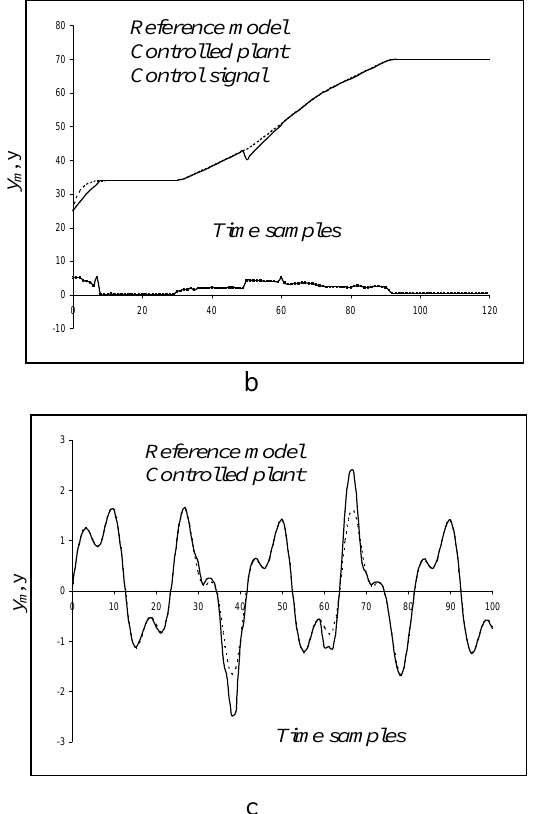
Fig. 6. Outputs of the reference model and the controlled plant when a disturbance is applied at the output of (a) Plant 1 (b) Plant 2 (c) Plant 3 objective functions against